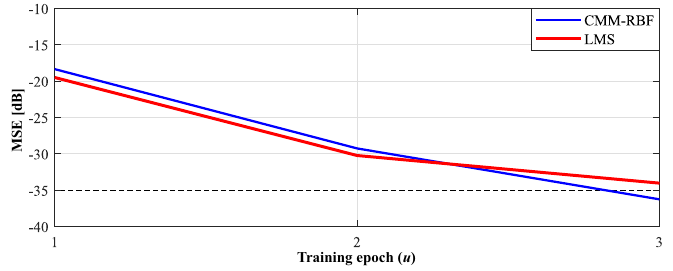
Figure 5. Mean squared error (MSE) of the complex multiple-input multiple-output radial basis function neural network (CMM-RBF) and least mean square (LMS) algorithms for three training epochs: uniform and circular array (UCA) with target ˆ ω = 160 ◦